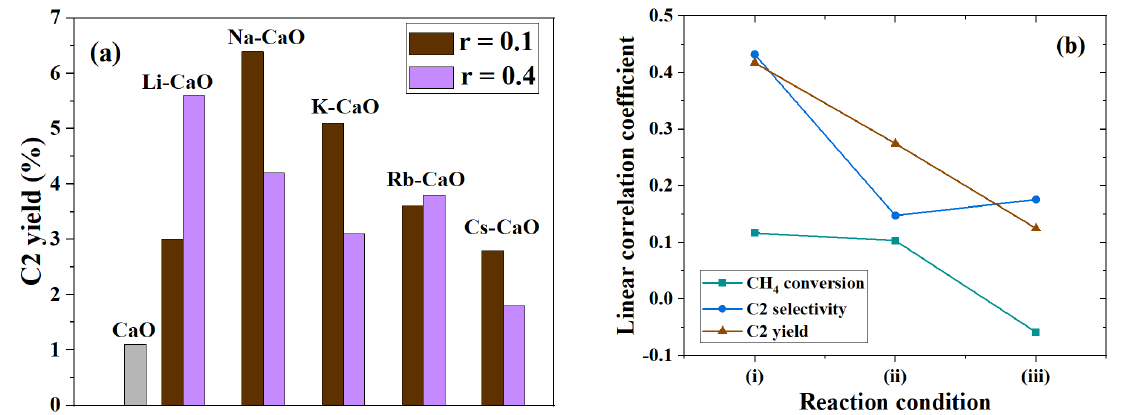
Figure 30. ( a ) C2 yield for different bimetallic catalysts obtained at 700 °C and CH 4 /O 2 of 4.0. In the figures, r denotes the alkali metal to Ca ratio. ( b ) Linear correlation coefficient between surface basicity, in mol·m 2 , and CH 4 conversion ( ■ ), C2 selectivity ( ● ) and C2 yield ( ▲ ) as a function of reaction conditions (( i ): 700 °C, CH 4 /O 2 of 4.0; ( ii ): 750 °C, CH 4 /O 2 of 4.0; ( iii ): 750 °C, CH 4 /O 2 of 8.0. Data sourced from [164].